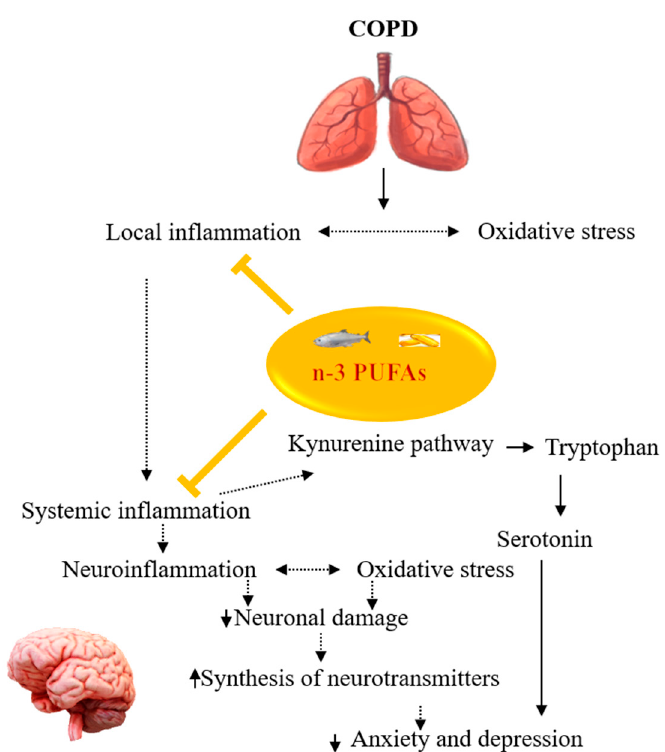
Figure 4. Summary of the potentials of n-3 PUFAs in managing COPD comorbid mood disorders. n-3 PUFAs can inhibit pulmonary and systemic inflammation thus reducing anxiety and depression in COPD. COPD: Chronic obstructive pulmonary disease, n-3 PUFAs: omega-3 polyunsaturated fatty acids.